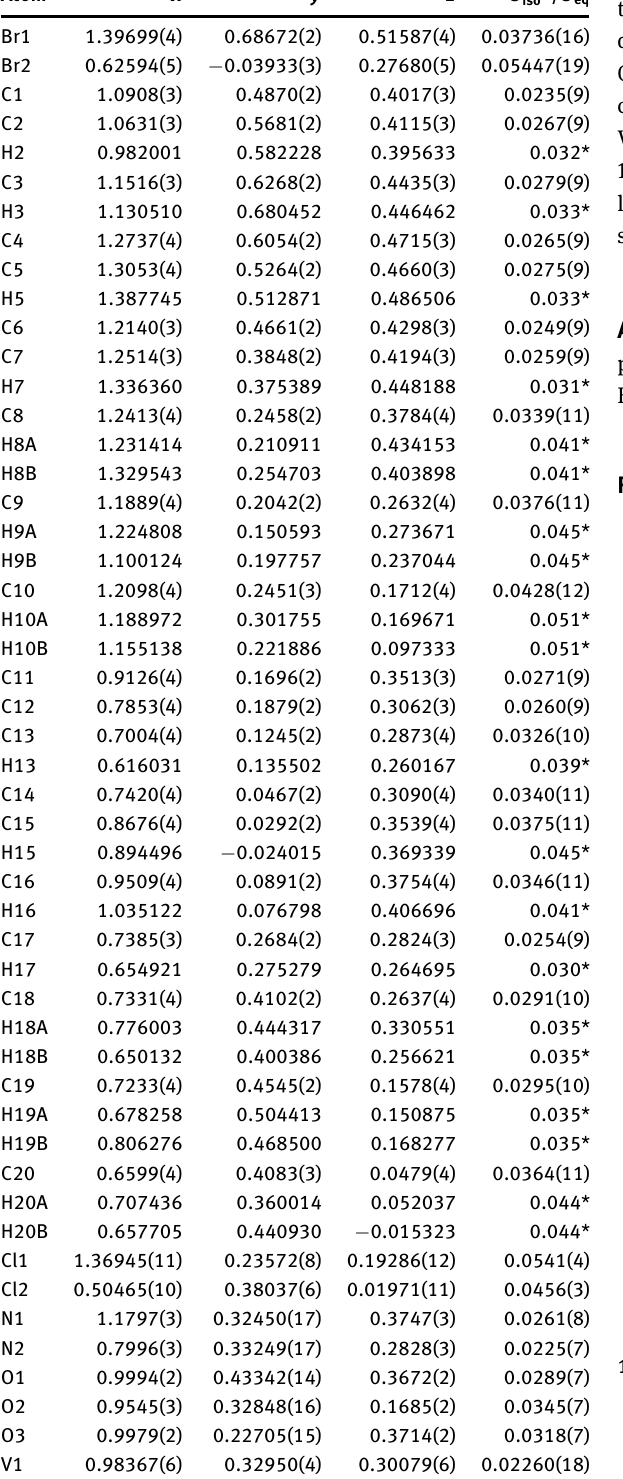
Table 2: Fractional atomic coordinates and isotropic or equivalent isotropic displacement parameters (Å 2